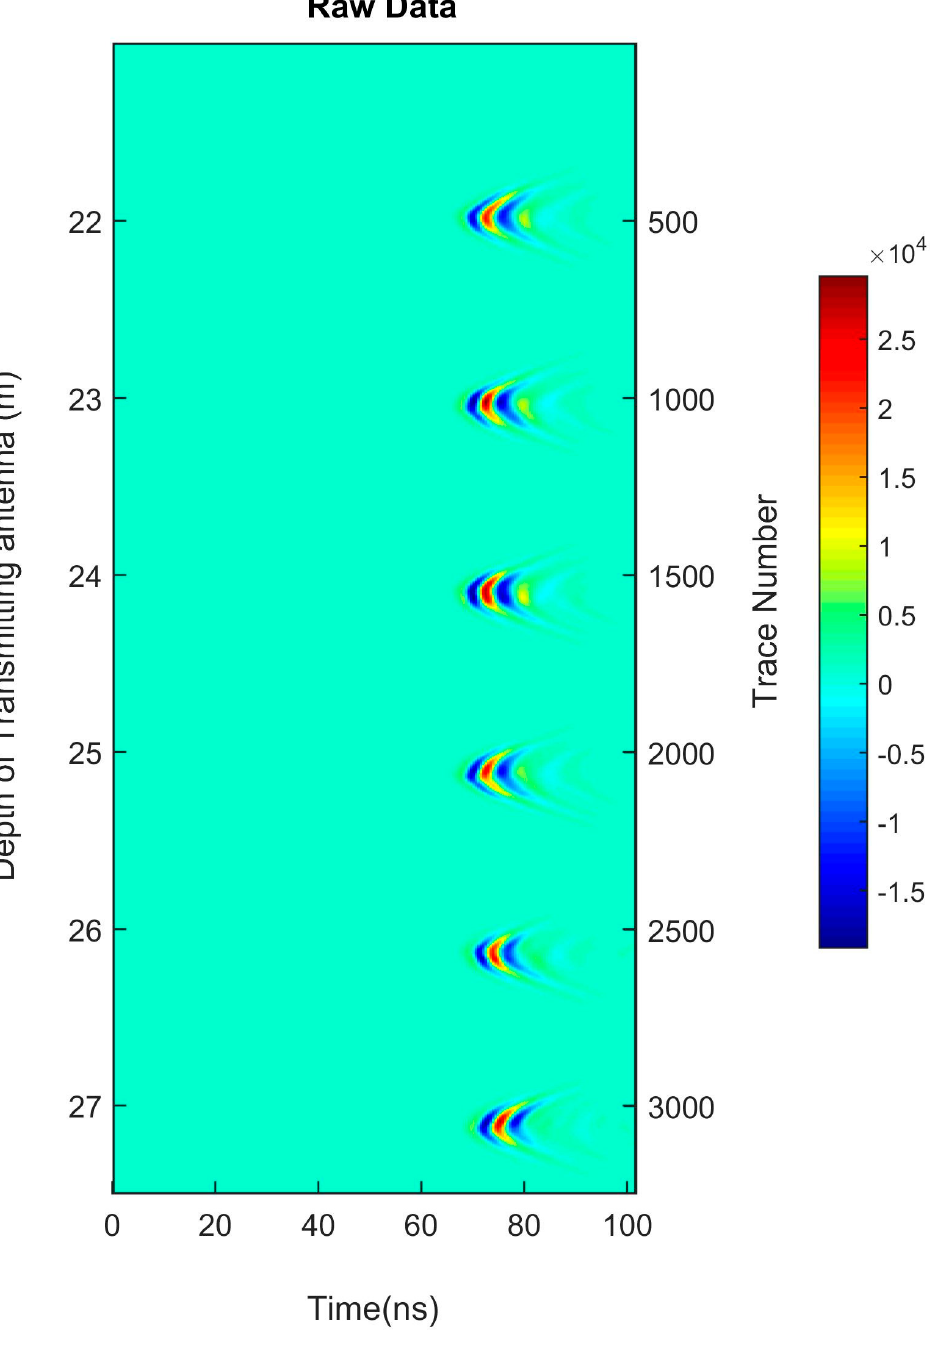
Figure 6. Raw data of the cross-hole radar measurement (in